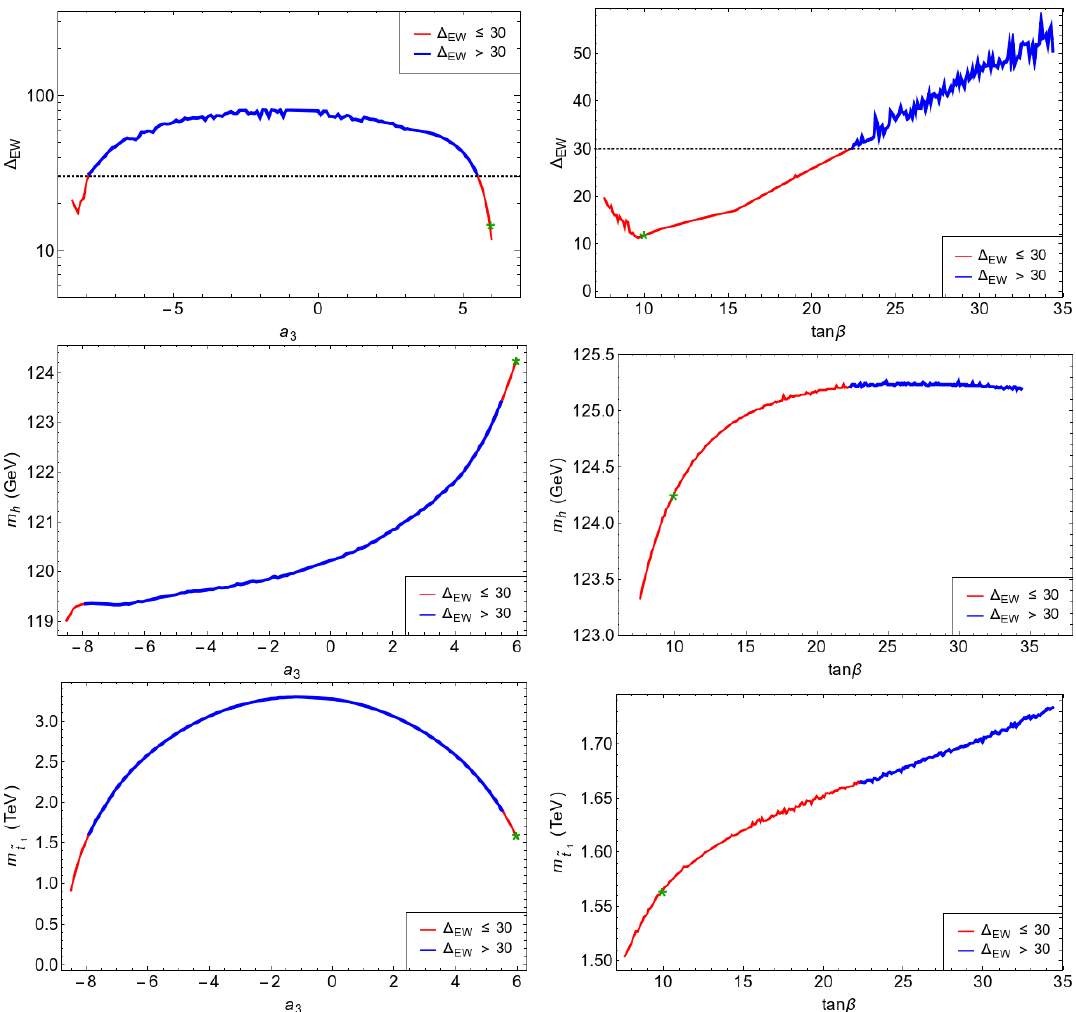
Figure 5 . (cid:1) EW , m h and m ~ vs. variation in a 3 and tan (cid:12) for the mini1 benchmark point. The t 1 red portion of the curves has (cid:1) EW < 30. The green star denotes the mini1 benchmark point. In (cid:12)gure 5, we show variation of (cid:1) , m and m ~ versus a (left-column) and tan (cid:12) 3 EW h t 1 (right-column). For much of the range of a , which dictates the magnitude of the trilinear 3 soft terms A , the solutions are relatively unnatural and the value of m is too low. For t;b;(cid:28) h large a (cid:24) 5{6, both the mixing in the stop sector and radiative corrections to m increase, 3 h leading to m (cid:24) 125 GeV whilst simultaneously reducing (cid:1) < 30. The value of m EW h h decreases for negative values of a because A (weak) (cid:24) 1 TeV for a < (cid:0) 6 to be compared 3 t 3 with A (weak) (cid:24) (cid:0) 4 TeV at the right end of the plot. The value of m ~ gets reduced for t t 1 values of a consistent with both naturalness as well as the observed value of m . For large 3 h negative a , the value of (cid:1) also drops below 30, but in this case m remains around 3 EW h 119 GeV. From the right-column, we see that low (cid:1) prefers low tan (cid:12) . 25. For higher EW (~ b tan (cid:12) , then the b -quark Yukawa increases and the (cid:6) u ) terms can contribute large values 1 ; 2 u to (cid:1) because the bottom squarks are typically heavier than the stops. EW